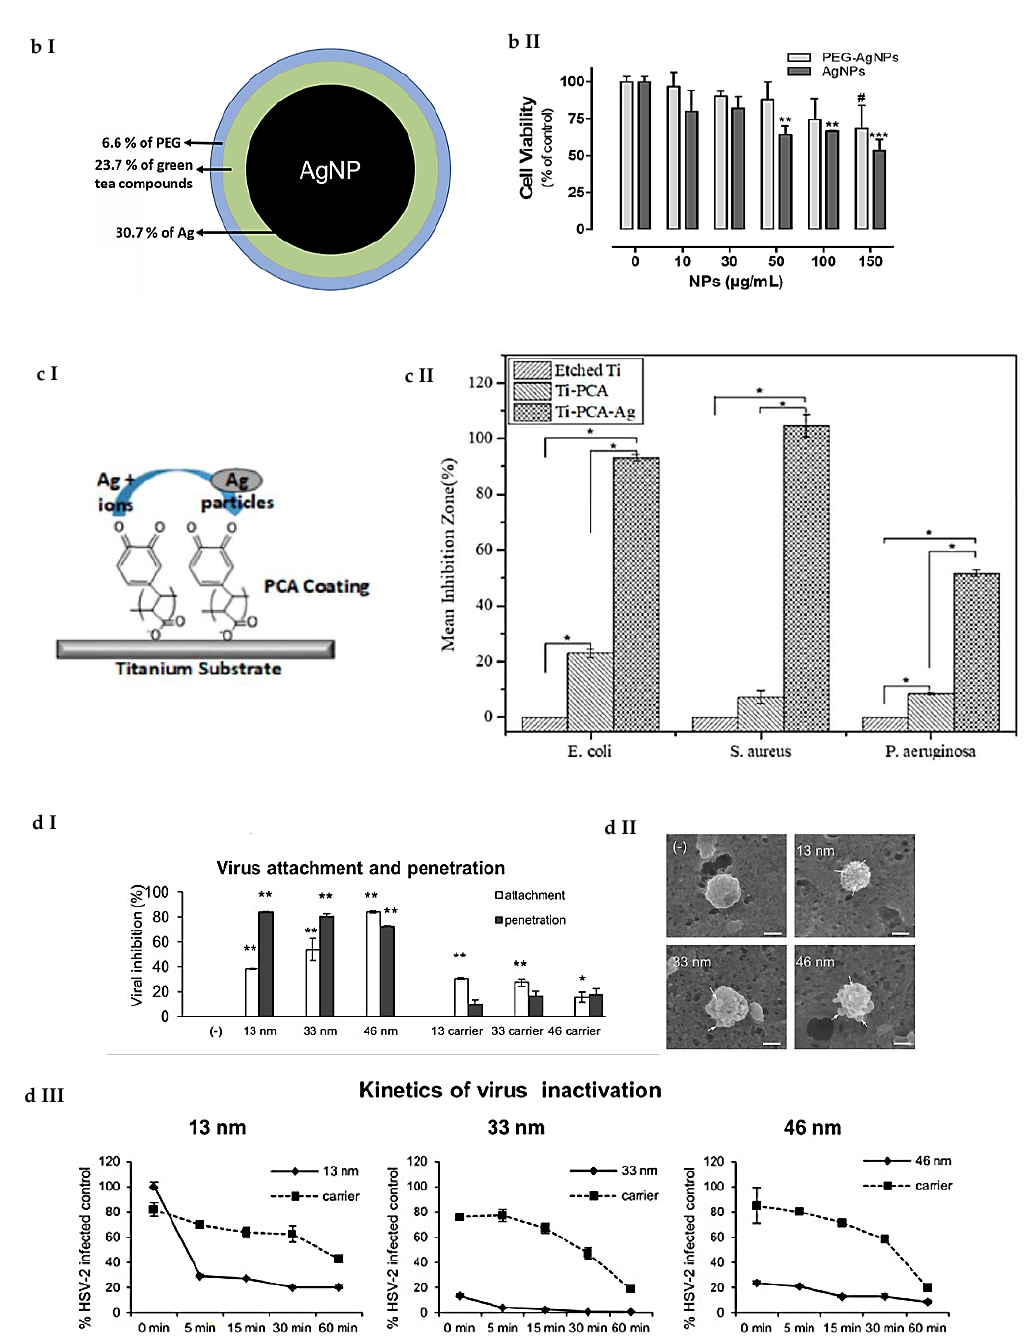
Figure 5. Examples of the result of the combination of phenolic compounds with AgNPs. ( a ) ( I ) Schematic diagram illustrating the fabrication and bactericidal process of cAgNPs as a kind of synergistic antibacterial agents; cell death rate of ( II ) B. subtilis and ( III ) E. coli bacteria after incubation with cAgNPs, PVP–AgNPs and CCM at different concentrations (12.5, 25, 50, 100, 200 µ g/mL) [191]. Copyright 2019 Elsevier. ( b ) ( I ) Schematic representation of the obtained AgNPs capped with green tea extract compounds and PEG: ( II ) HaCat cell viability after incubation with AgNPs and PEG-AgNPs at different concentrations for 24 h [198]. Copyright 2019 Elsevier. ( c ) ( I ) Schematics of the process of synthesis of metallic silver (Ag) on the polycaffeic acid (PCA) on etched titanium (Ti) substrate Ti–PCA [200]; ( II ) graph of inhibition zone for three strains of E. coli , S. aureus and P. aeruginosa for PCA, PCA–Ti and PCA–Ti–Ag [201]. ( d ) ( I ) Viral inhibition (%) for virus attachment and penetration experiments with the use of 33 nm and 46 nm AgNPs and 13 nm AgNPs and corresponding carriers; ( II ) SEM images in EDS mode of HSV-2 virus incubated with AgNPs of different sizes (13, 33, 46 nm).White arrows point out on the interaction spot of the NPs with the surface of virion; white bars indicate 100 nm; ( III ) kinetics of AgNPs and HSV-2 interaction expressed as % of HSV-2-infected positive controls